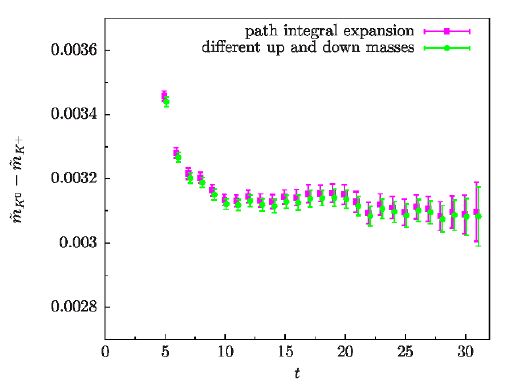
Figure 8 . The strong isospin breaking contribution to the di(cid:11)erence of the charged and neutral kaon masses. Green circle points are results using di(cid:11)erent bare quark masses for up and down quark, purple square points are results using the expansion of the path integral. Both data sets use the same m d (cid:0) m u